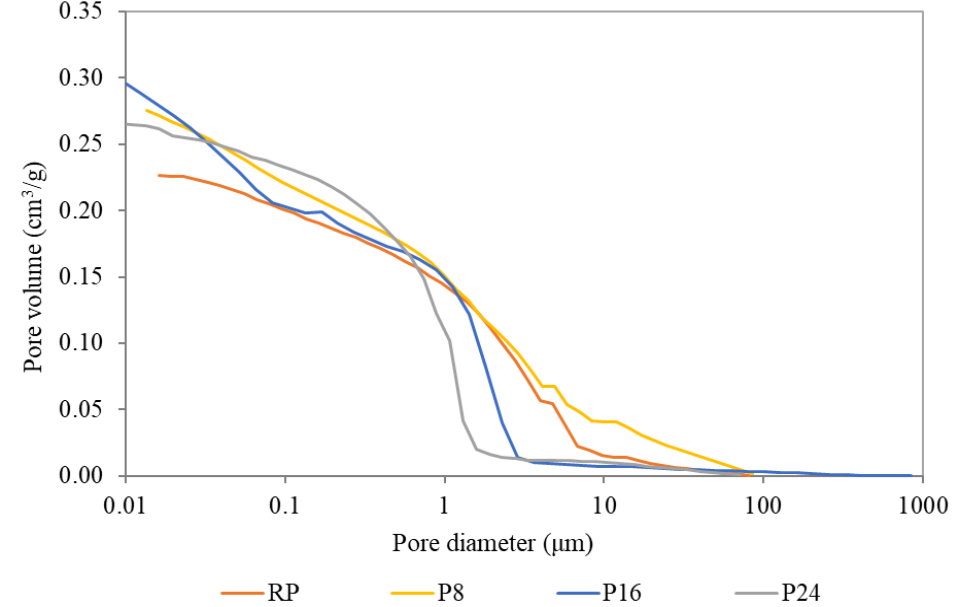
Figure 2. Pore diameter distribution of the studied plasters.